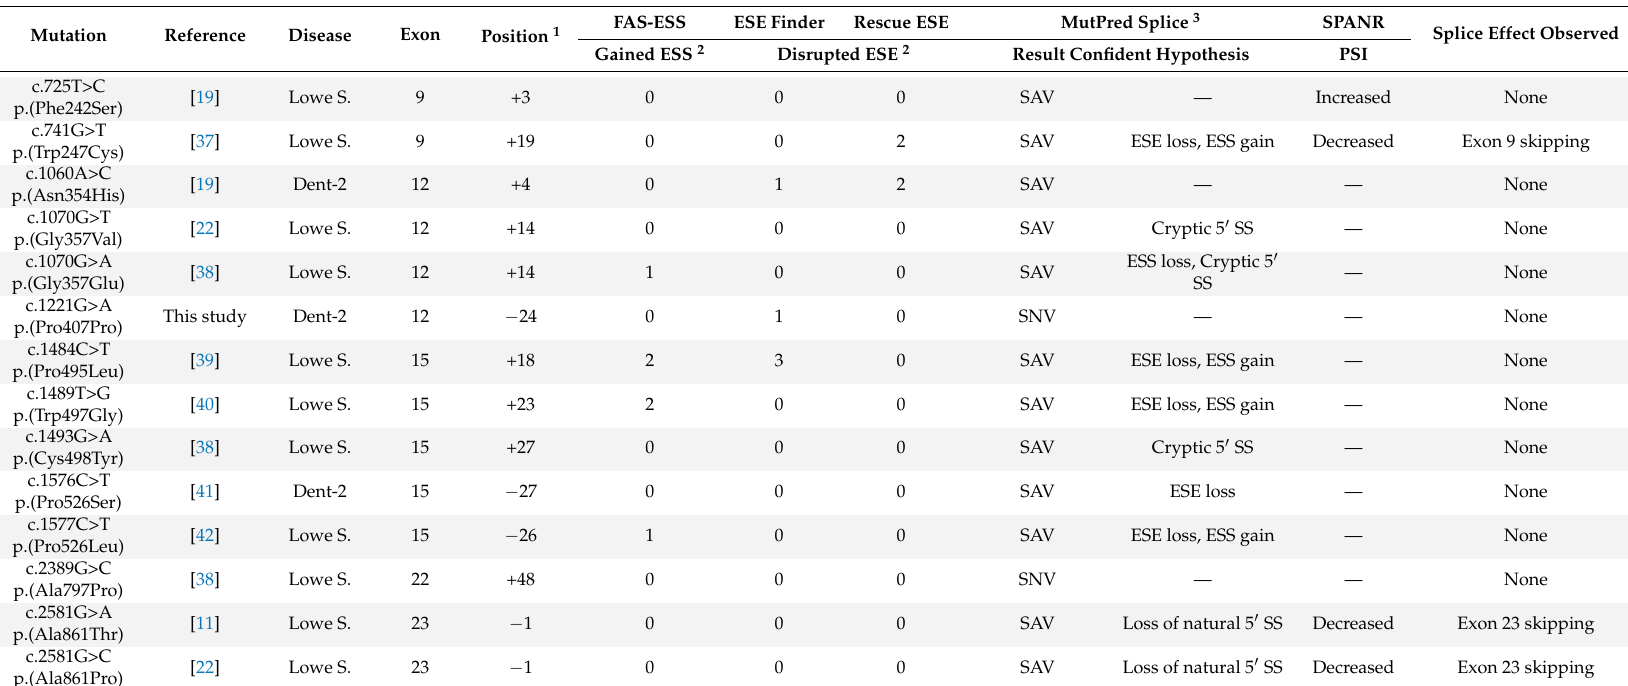
Table 1. Mutations analyzed with the minigene